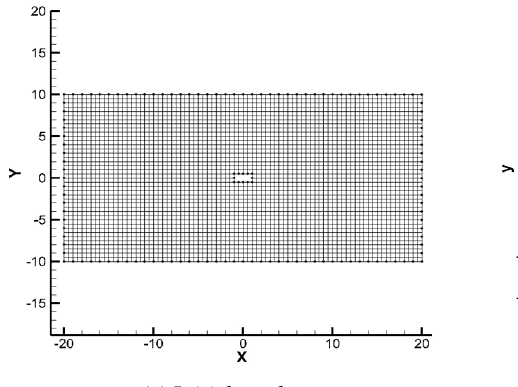
Figure 2. Mesh of test case 1.